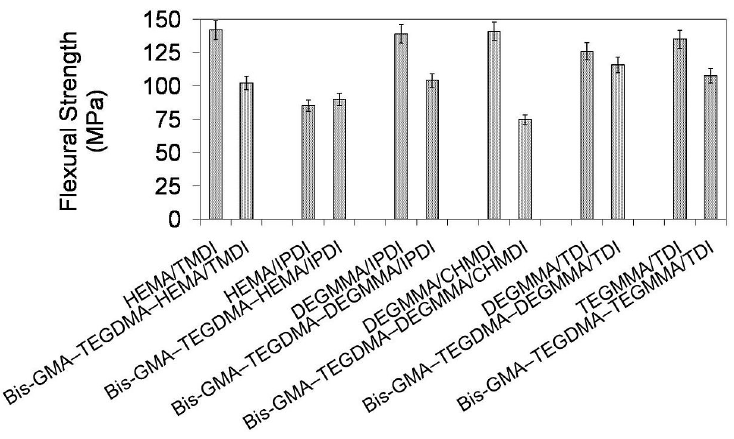
Figure 10. The flexural strength of homopolymers and copolymers composed of UDMA, Bis-GMA and TEGDMA.